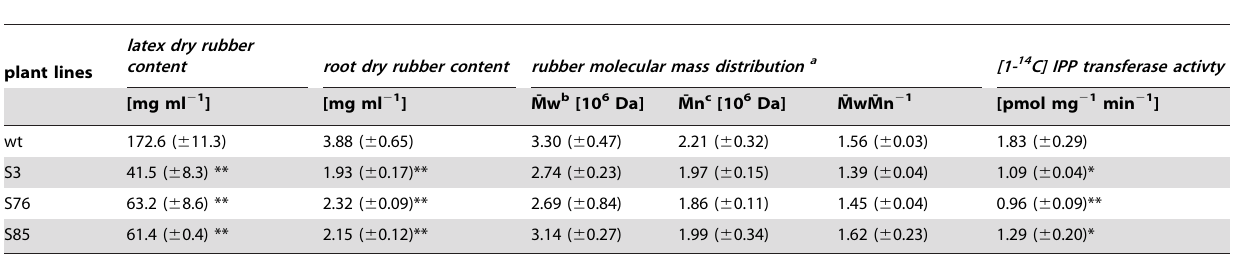
Table 1. Content, molecular mass and polydispersity of rubber from exuded latex and freeze-dried roots and corresponding long- chain prenyltransferase activity.